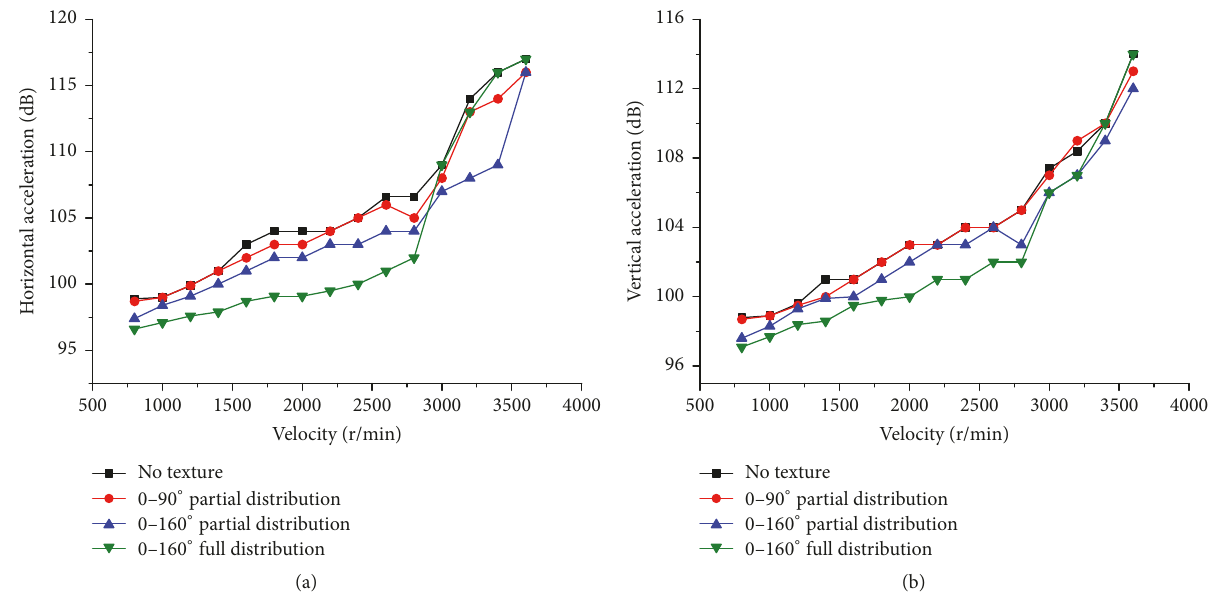
Figure 4: Textures configurations on the bearing surface for the 4 cases.